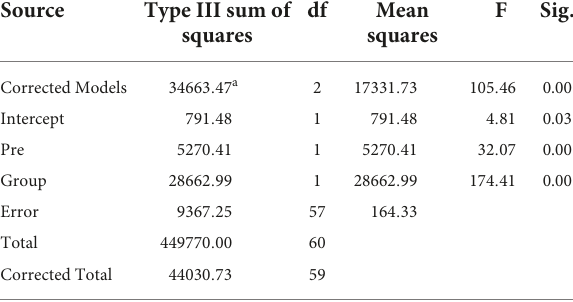
TABLE 2 Inferential statistics of both groups on the anxiety